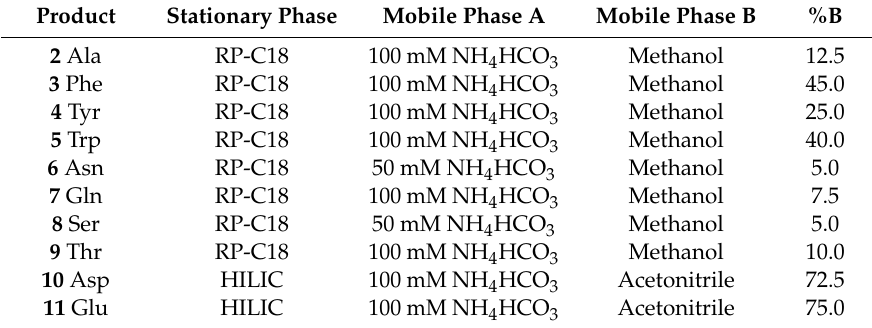
Table 5. Chromatographic conditions used for purification of the crude products by preparative